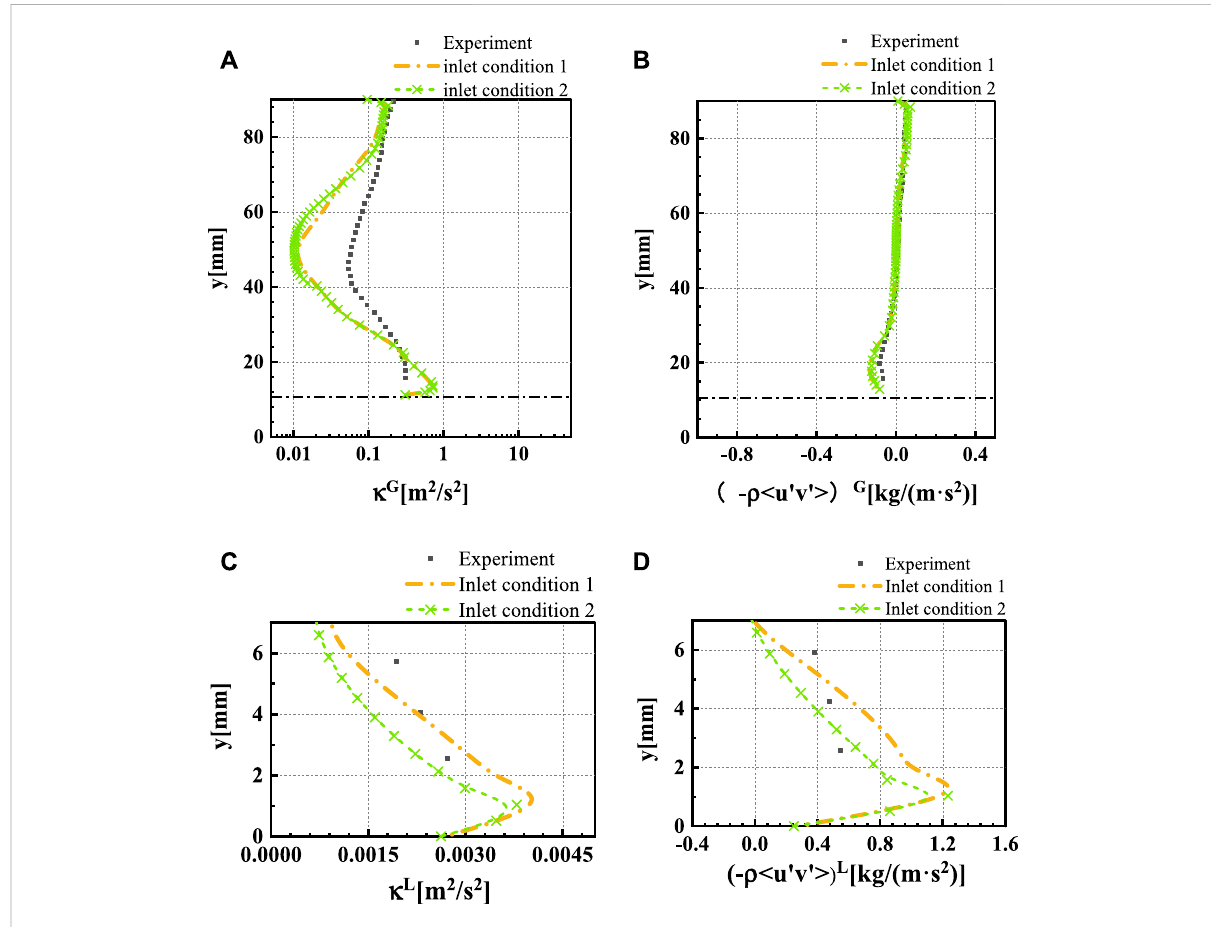
FIGURE 9 Turbulent kinetic energy ( κ ) and Reynolds stress component ( - ρ < u ’ v ’ > ) at MP1 under different inlet conditions, (A) turbulent kinetic energy distributionofthegasphase, (B) Reynoldsstresscomponentdistributionofthegasphase, (C) turbulentkineticenergydistributionoftheliquidphase, (D) Reynolds stress component distribution of the liquid